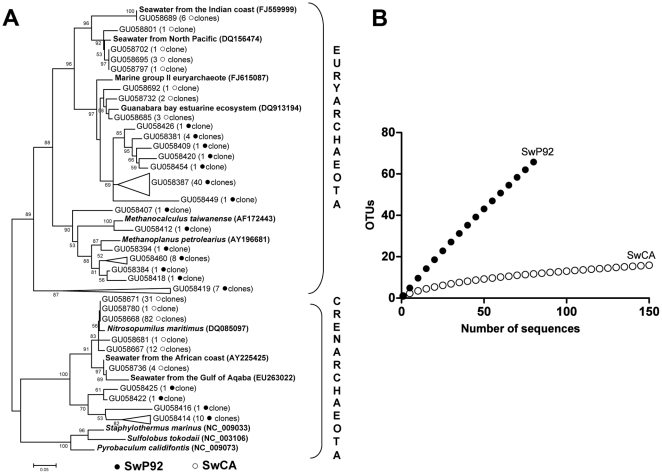
Planktonic archaeal communities.(A) Phylogenetic construction: Neighbour-joining 16S rRNA unrooted tree (•) inner bay (P92) clones (○) Cagarras Archipelago (CA) clones (B) Rarefaction analysis at 97% stringency (•) inner bay (P92) sequences (○) Cagarras Archipelago (CA) sequences.